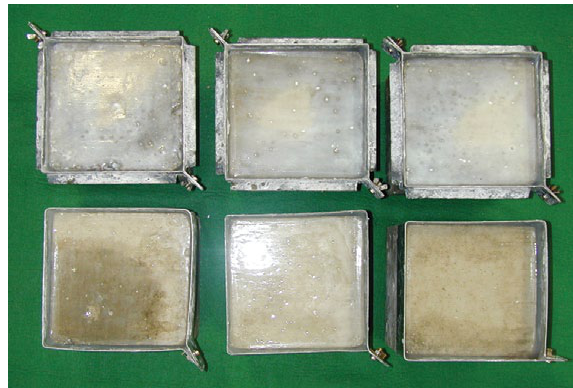
Fig. 4. Change in appearance of a film (areal dimensions 150×150 mm) of the old (upper three samples) and new (lower three samples) dispersions after 60 freezing cycles in an environment of the 3% NaCl solution. The substrate of the dispersion film is ordinary cement concrete with a 28-day compressive strength of 30 is also apparent in the new dispersion, specifically on the first testing cube (see Fig. 4, bottom left sample).